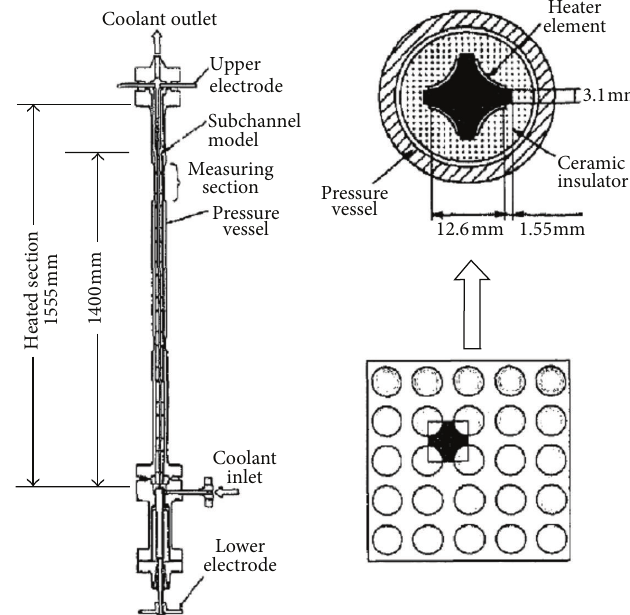
Figure 2: Test section for central subchannel void distribution measurement.